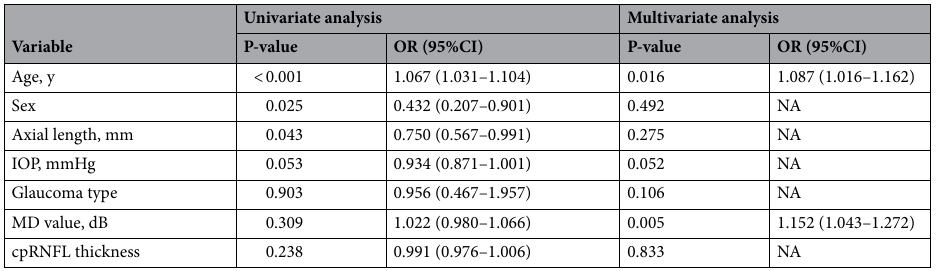
Table 4. Logistic regression analysis of variables associated with concentric/temporal shape of parapapillary beta zone. All the univariate variables in the table are included in the multivariate analysis. OR: odds ratio; CI: confidence interval; MD: mean deviation; RNFL: retinal nerve fiber layer; IOP: intraocular pressure.